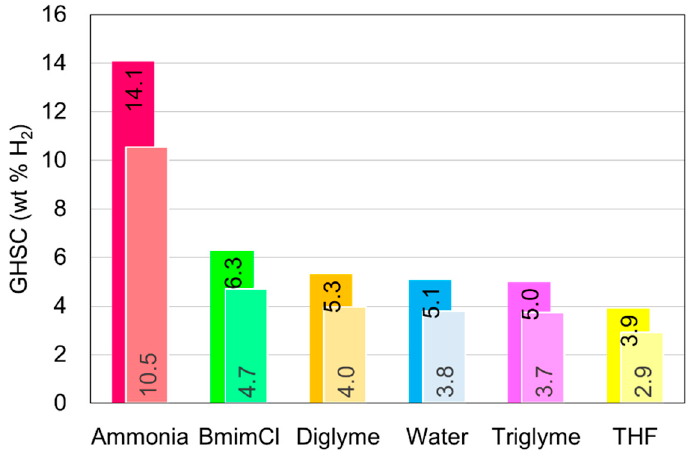
Figure 11. Proposed thermolytic dehydrogenation pathways of ammonia borane in triglyme: ( a ) for high concentrations of ammonia borane, ( b ) for low concentrations of ammonia borane. With DADB for diammoniate of diborane, CDB for cyclodiborazane, BCDB for B-(cyclodiborazanyl)aminoborohydride, CTB for cyclotriborazane, µADB for µ-aminodiborane and BZ for borazine. Adapted from ref. [194].